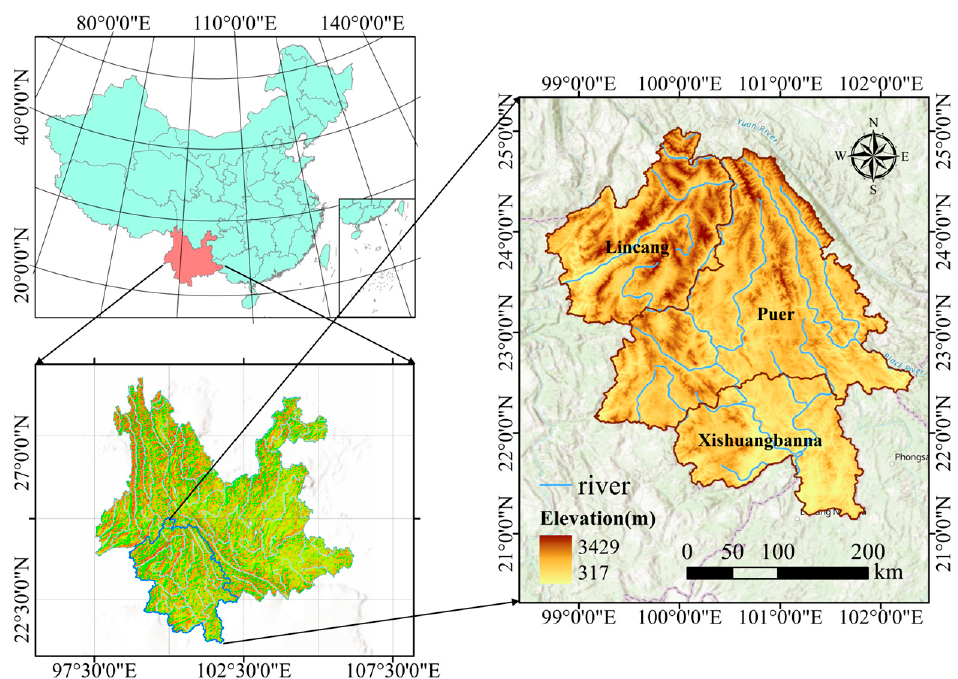
Figure 1. Location of the study area.